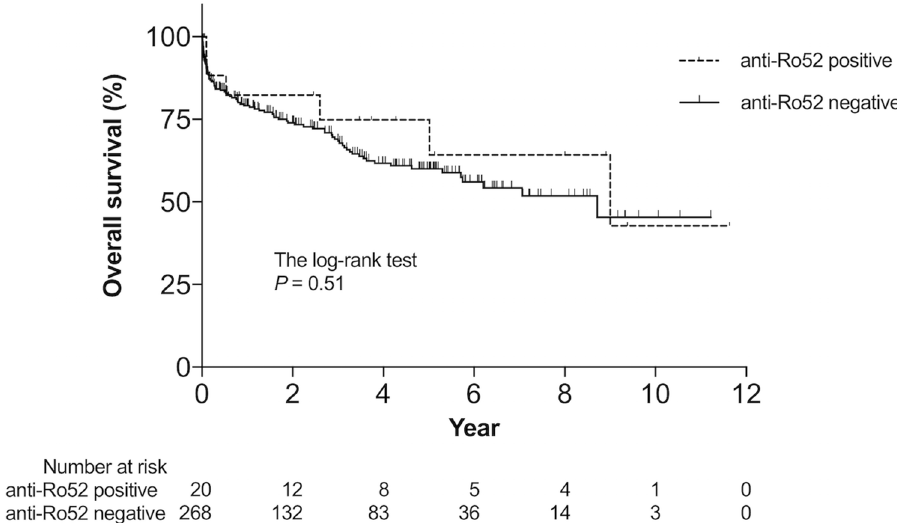
Figure 1. Kaplan–Meier survival curves of idiopathic interstitial pneumonia (IIP) patients with/without anti-Ro52/tripartite motif-containing 21 antibodies (anti-Ro52). Kaplan–Meier curves representing the survival rate of IIP patients in the presence (dotted line; n = 20) and absence (dashed line; n = 268) of serum anti-Ro52. Statistically relevant difference was not observed between the analyzed groups (log-rank P =